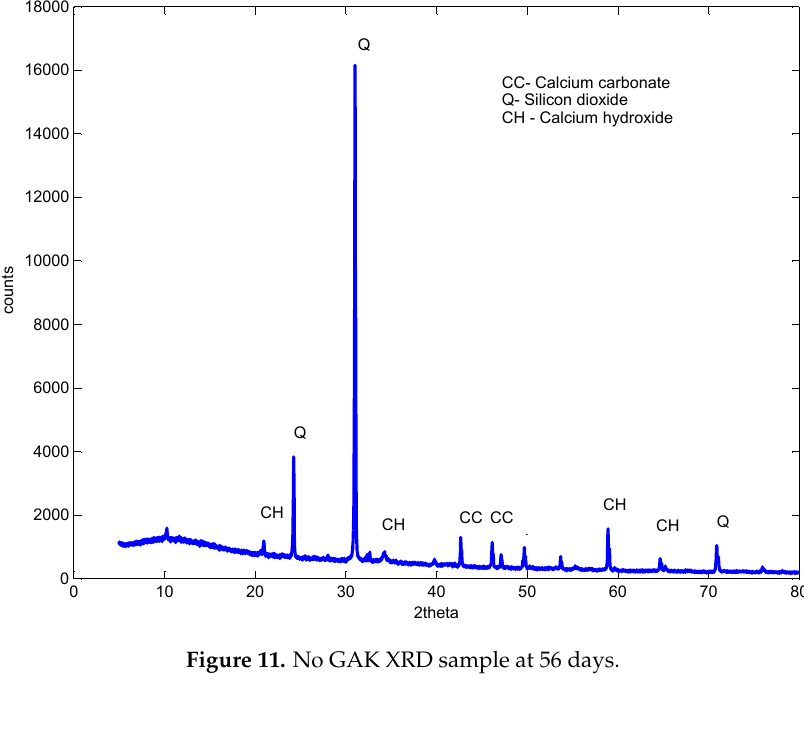
Figure 11. No GAK XRD sample at 56 days.